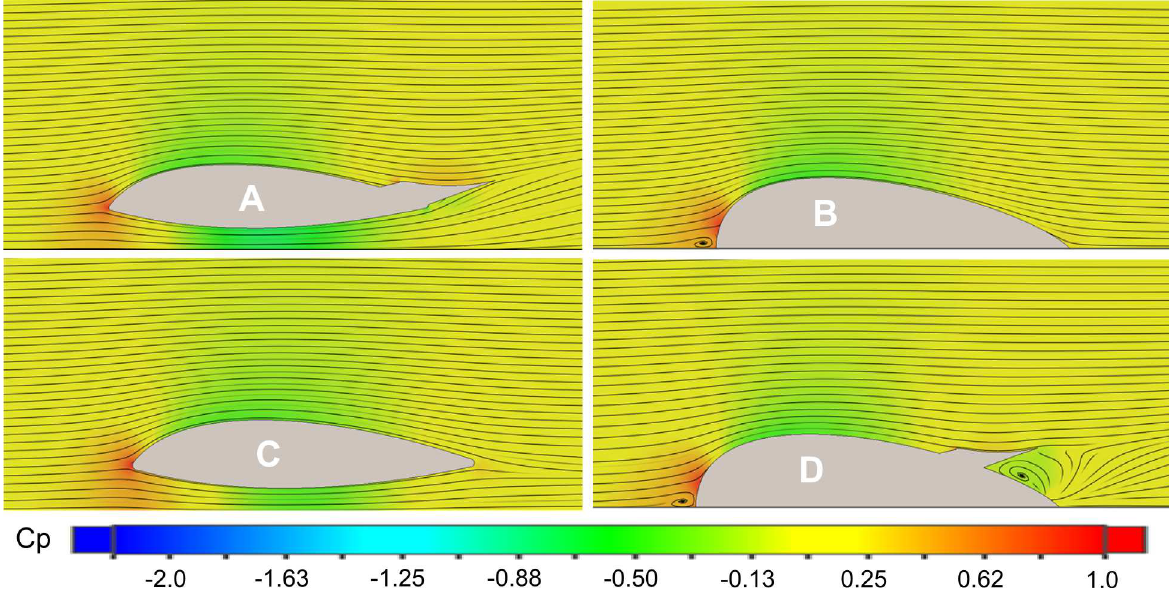
Fig 6. Longitudinal cross-section views in 5.6 m/s inline flow with a color map corresponding to the coefficient of pressure ( Cp ). Areas of low pressure are shown in green, whileareas of high pressure are shown in